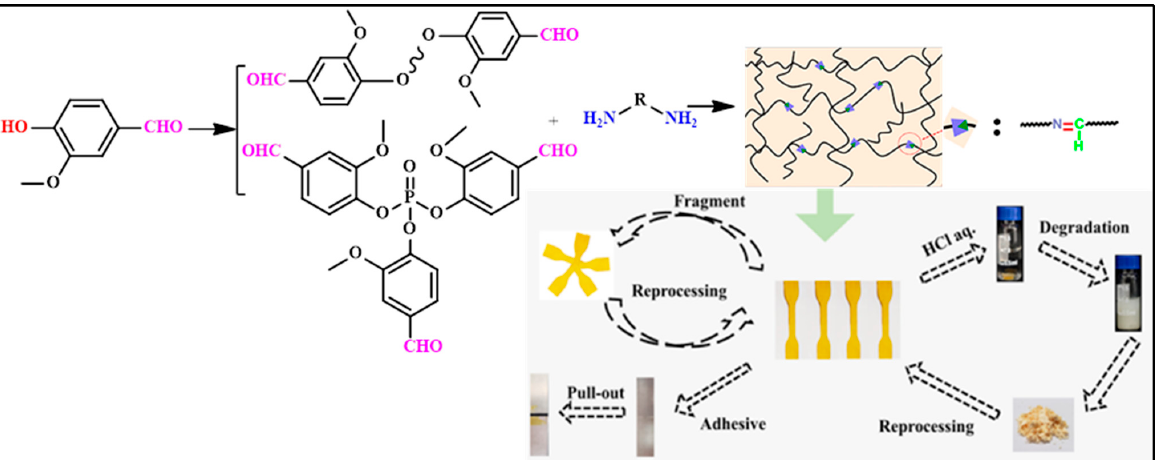
Figure 18. Synthesized routes of completely biobased reversible polyimine vitrimer from sustainable vanillin and amine, and its thermal and chemical recyclability [reproduced with permission from Zhou et al.; published by ACS, 2020] [13].